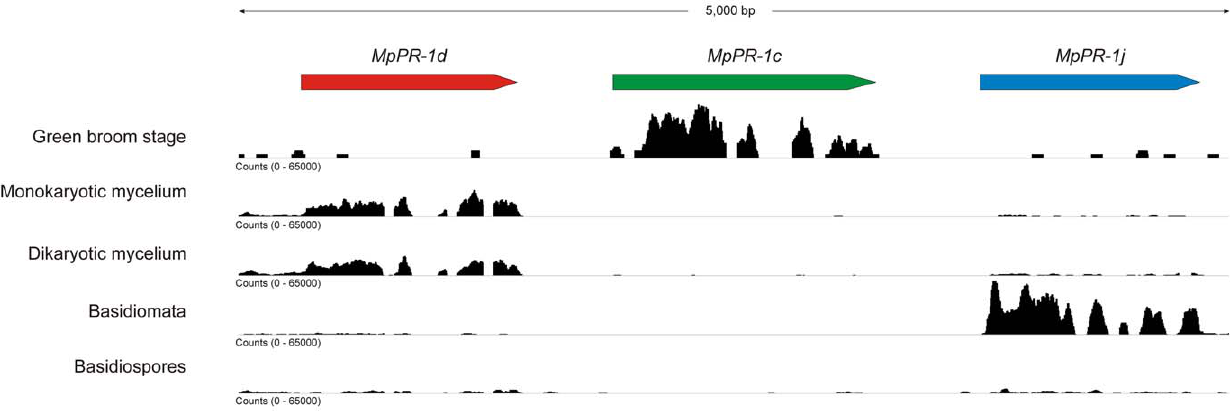
Figure 5. Genomic organization and transcriptional profile of the MpPR-1 gene cluster found in M.perniciosa . The MpPR-1c , MpPR-1d and MpPR-1j genes are arranged in tandem over a region of approximately 5 kbp. Analysis of the WBD RNA-seq Atlas shows the expression profile of these MpPR-1 genes in different conditions (green broom – in planta development of the biotrophic monokaryotic hyphae; monokaryotic mycelium; dikaryotic mycelium; basidiomata and basidiospores). Data were visualized using the Integrative Genomics Viewer [62]. The black coverage plot shows cumulative RNA-seq read coverage along the transcripts in all different conditions. Note that these genes were named according to the order they were identified in the fungal genome, and the nomenclature does not necessarily reflect their relative localization in the